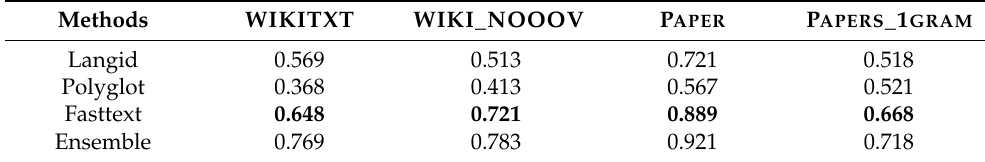
Table 1. Accuracy of the off-the-shelf